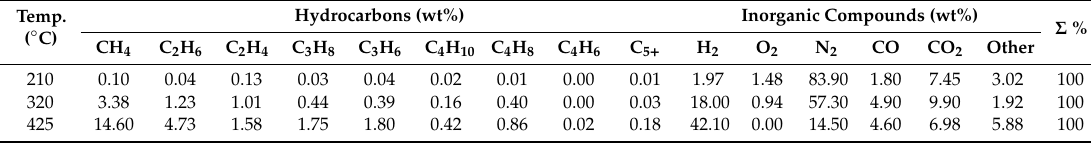
Table 3. Gas composition, preconsumer material, 425 °C.